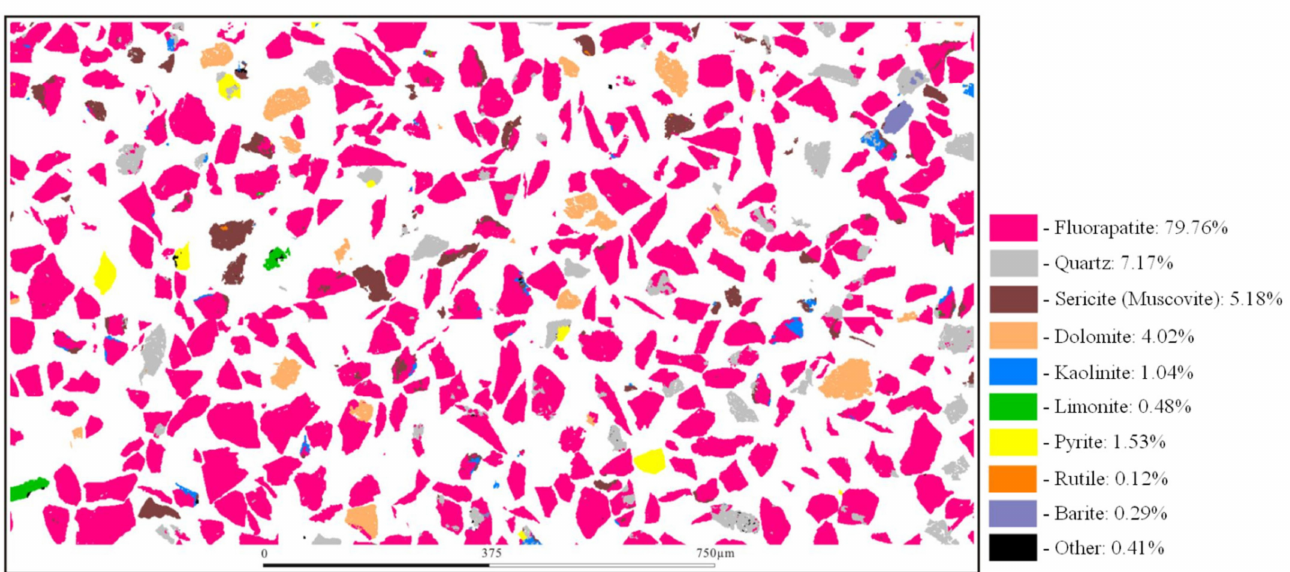
Figure 3. Particle phase diagram of collophanite with particle size of − 75 µ m accounting for 63% identified by AMICS.